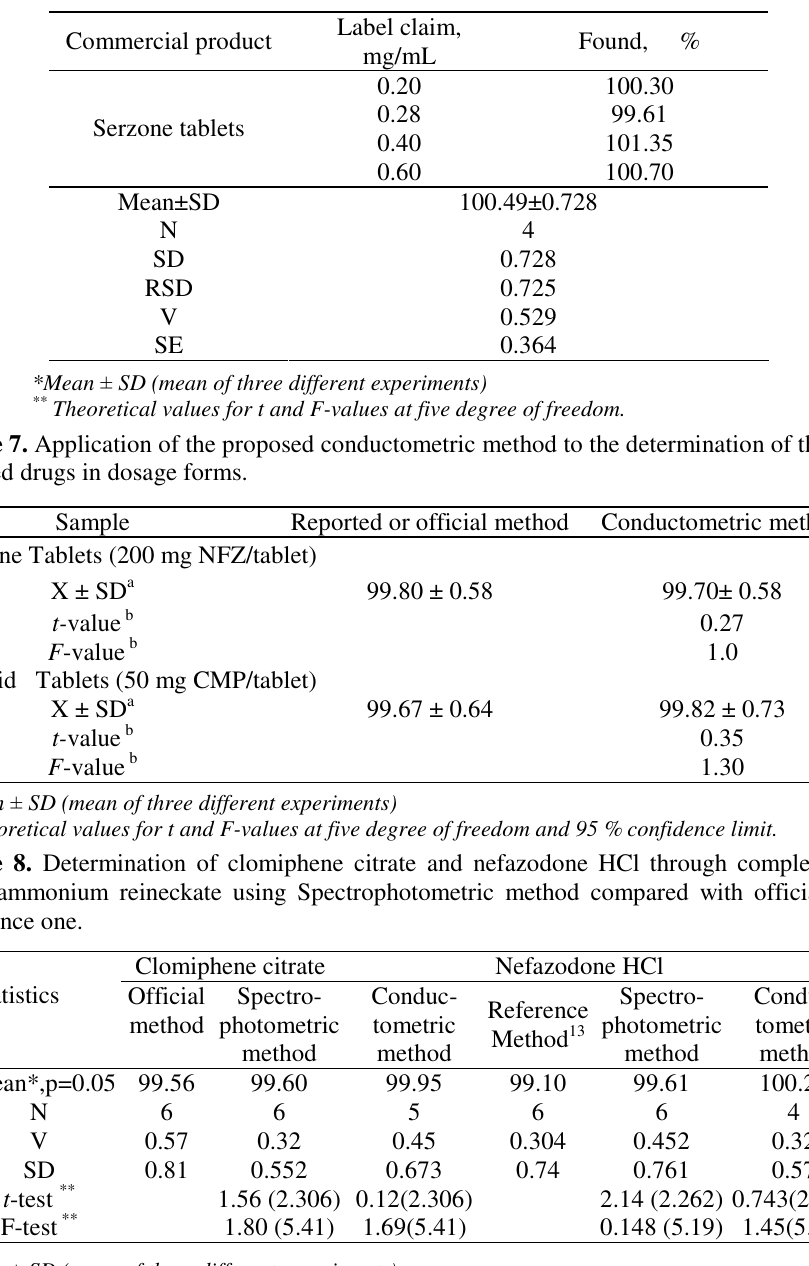
Table 6. Determination of nefazodone HCl in its pharmaceutical preparation by using spectrophotometric method.